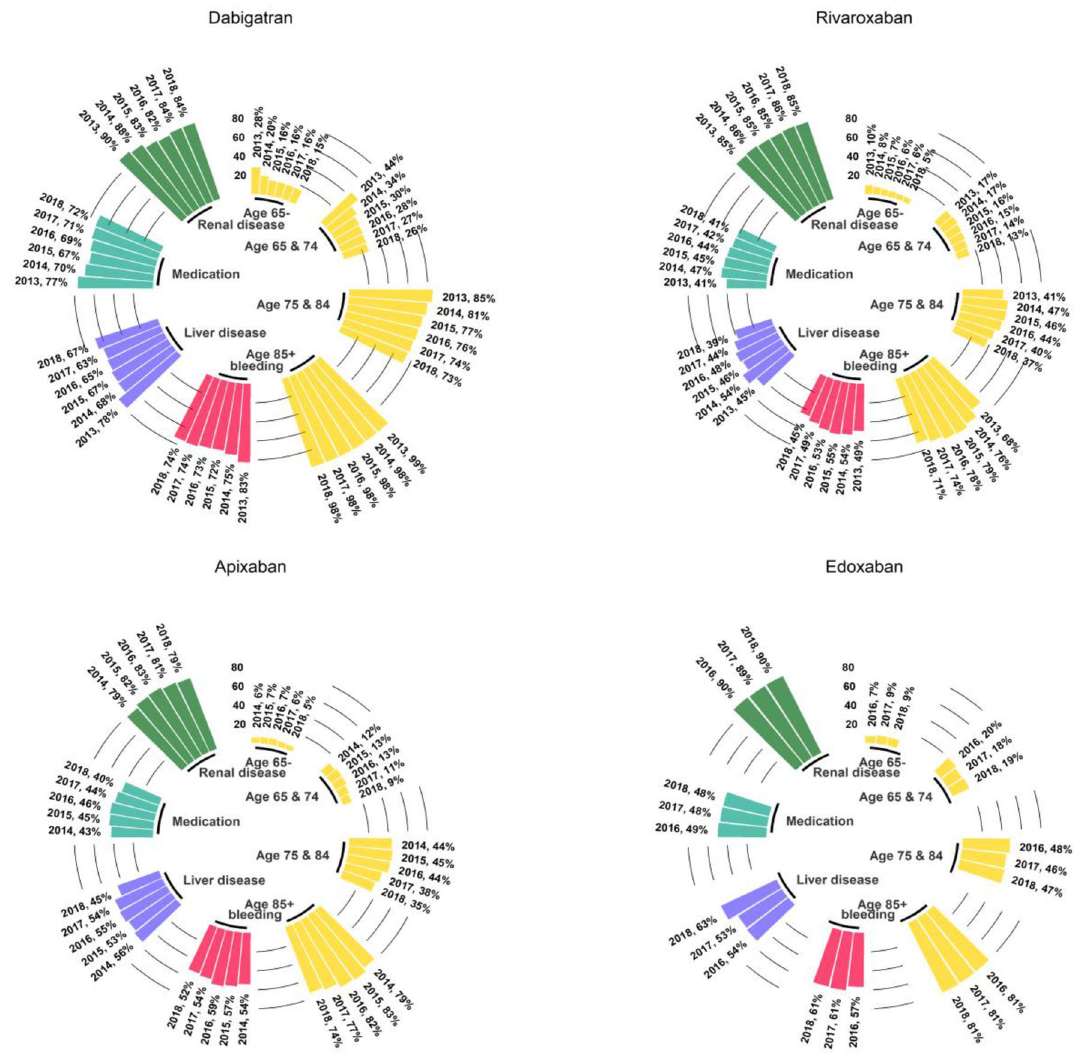
ggplot2 package 10